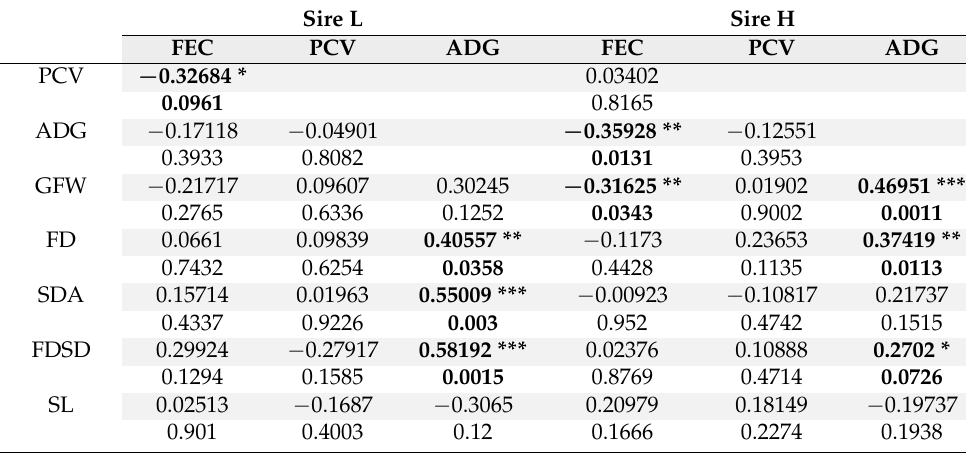
When correlations were analyzed by sire (Table 3), there was a negative correlation between FEC and both GFW and ADG for sire H ( − 0.32, p = 0.0343; − 0.36, p = 0.0131). A negative correlation trend was observed between FEC and PCV for sire L ( − 0.33, p = 0.0961). Average daily gain was positively correlated with FD, FDSD, and SDA for sire L (+0.41, p = 0.0358; +0.56, p = 0.0028; +0.52, p = 0.0057). Average daily gain was positively correlated with GFW and FD (+0.34, p = 0.0198; +0.37, p = 0.01) and tended to be positively correlated with FDSD (+0.27, p = 0.0726) for sire H. Table 3. Pearson’s correlation coefficients by sire (with p -values located below each correlation) between fecal egg count (FEC), packed-cell volume (PCV), and average daily gain (ADG) and grease- fleece weight (GFW), fiber diameter (FD), fiber diameter standard deviation (FDSD), and standard deviation along the fiber (SDA) and staple length (SL) in Rambouillet lambs. Lambs were sheared 4 months after an artificial H. contortus challenge, at approximately one year of age. Significant correlations and trends are in bold. Sire L Sire